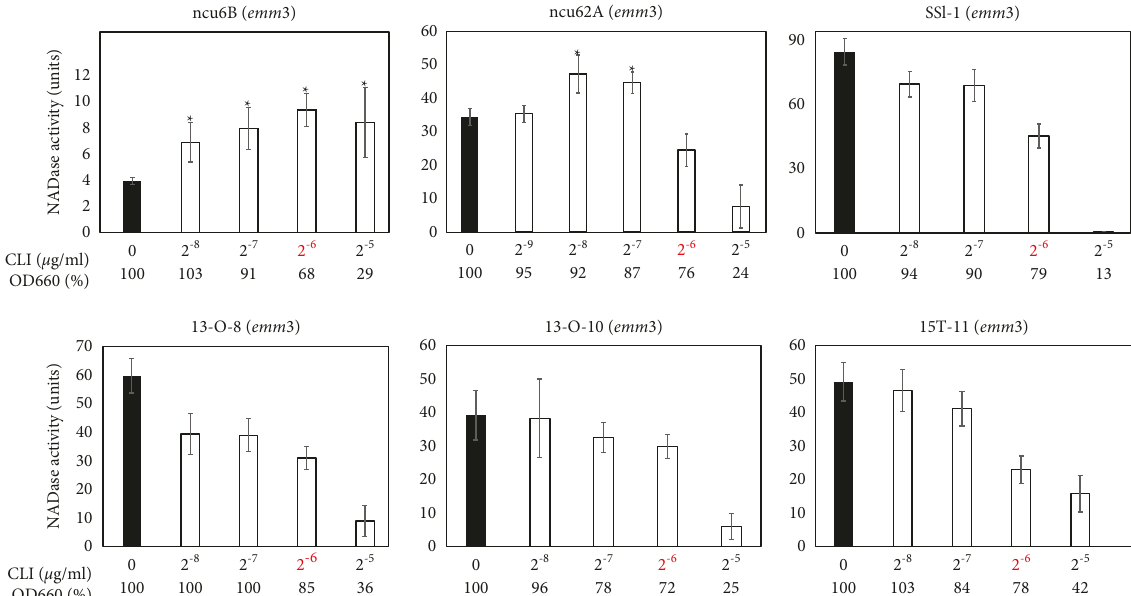
Figure 2: Extracellular NADase activity in S. pyogenes emm 3-type strains cultured with CLI. NADase activity was determined based on the criteria described in Figure 1. The OD 660 of overnight culture with CLI (2 − 8 to 2 − 5 μ g/ml) is shown by a percentage (%) of that without CLI (0 μ g/ml). The maximum CLI concentration that did not suppress the bacterial growth to less than 50% of that without CLI is shown in red, which was 2 − 6 μ g/ml in all the strains. At least three independent experiments were performed. Error bars indicate the standard errors of the means. Significant increases in extracellular NADase activity by CLI treatment when compared with that without CLI treatment, which is shown by the black bar, are marked with asterisks ( ∗ p < 0 . 05 using Student’s t -test).